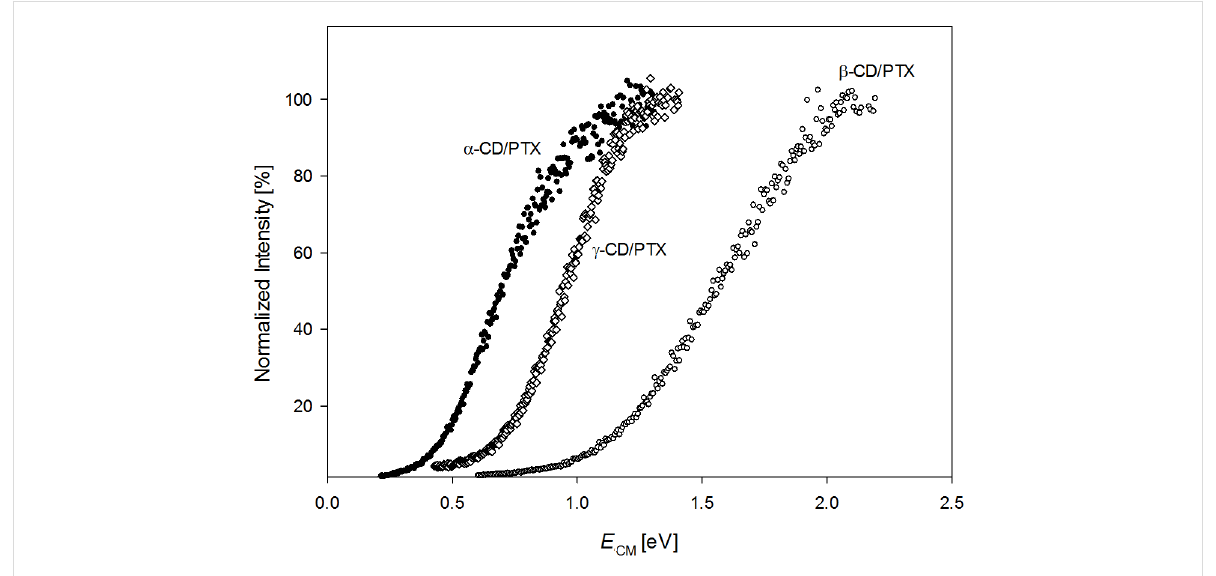
Figure 2: Dissociation efficiency curves of three CDs/PTX complexes. The ions were collided with nitrogen (pressure ca. 2 × 10 − 5 Torr) at various collision energies. The y axis represents the normalized intensity of the PTX anion ([PTX − H] − ) in proportion to the intensity of a complex ([CD + PTX − H] 2 −